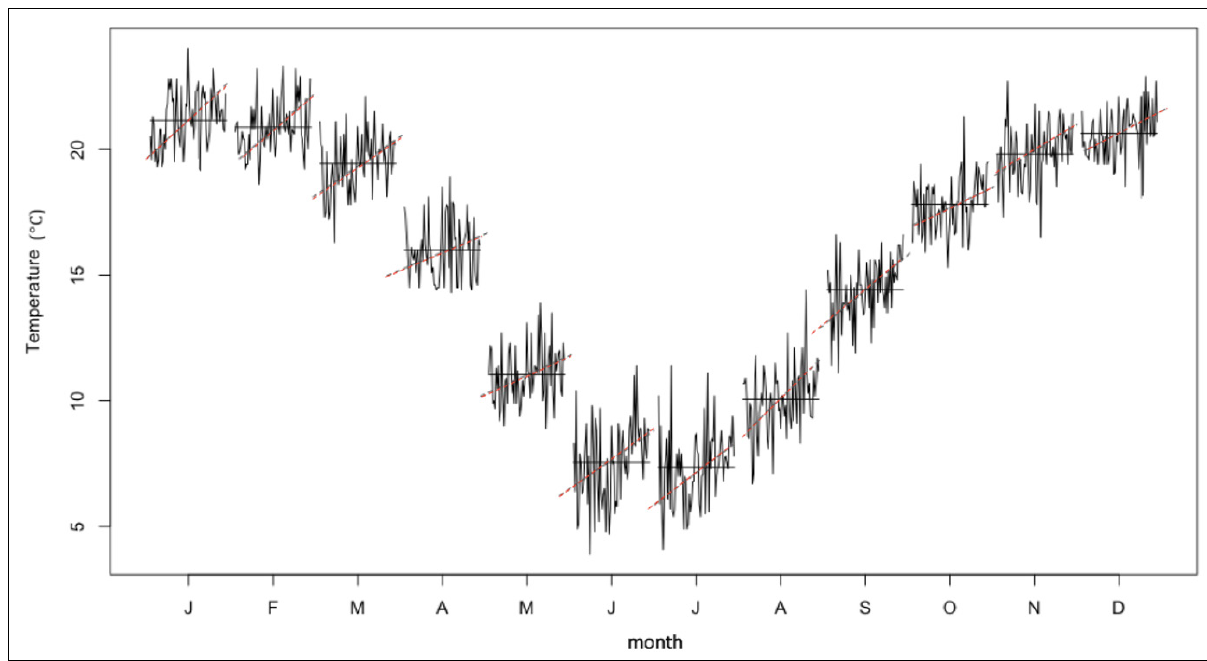
Figure 4: Mean monthly minimum temperatures for northernmost Limpopo Province, 1950–2016. Horizontal lines represent monthly mean values and red dotted lines represent trend lines. Table 1: Monthly temperatures for northernmost Limpopo Province, 1950-2016 Trends in temperature Mean temperature range Maximum Minimum Maximum temperature +0.02 °C/year Mean temperature Maximum